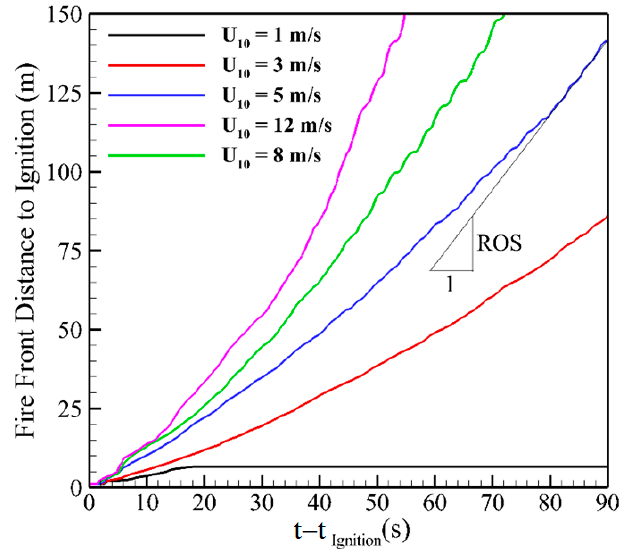
Figure 12. Time evolution of the average position of the fire front at the grassland surface obtained for different wind speeds. The rate of spread (RoS) is the slope of the curve at steady fire propagation. The fireline intensity, shown in Figure 13 per unit of fireline length (i.e., the domain width), was